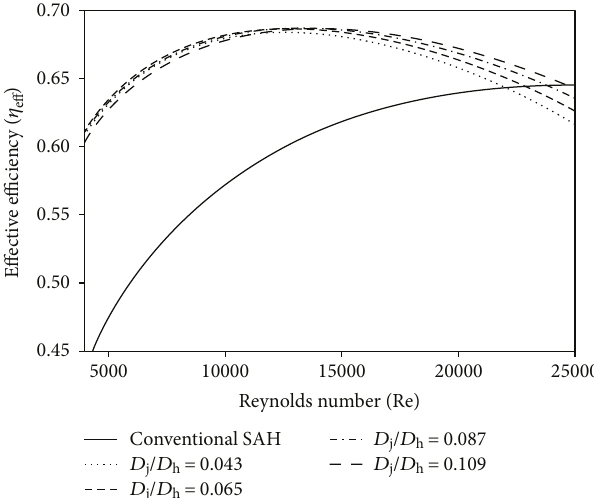
Figure 8: Variation of e ff ective e ffi ciency with Reynolds number at di ff erent values of jet diameter ratio